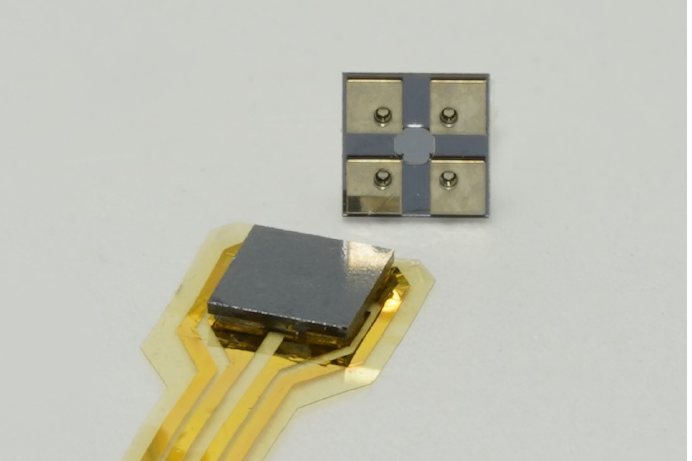
Figure 7. Photography of the sensor, soldered onto polyimide substrate and ready for flush integra- tion into composite material ( left ). Sensor’s bottom view showing through glass vias of the CSP ( right ) with outer dimensions of 2.2 × 2.2 × 0.2mm 3